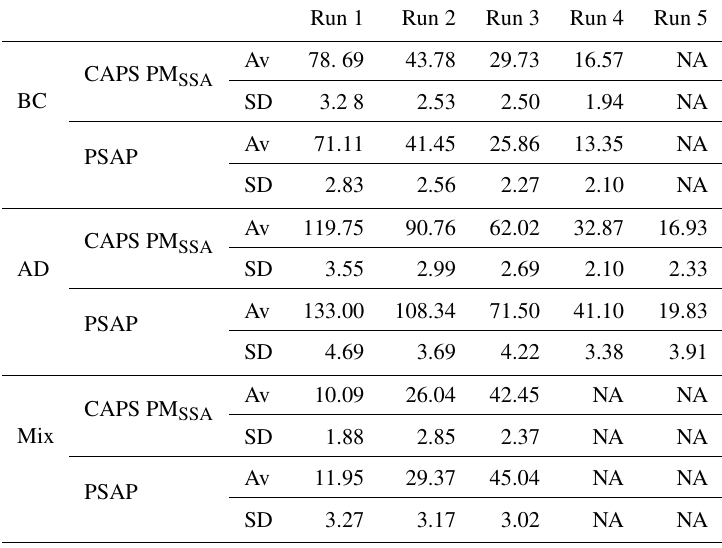
Table A3. Absorption coefficient mean and standard deviation of the mean measured by the CAPS PM SSA (extinction minus scattering) and